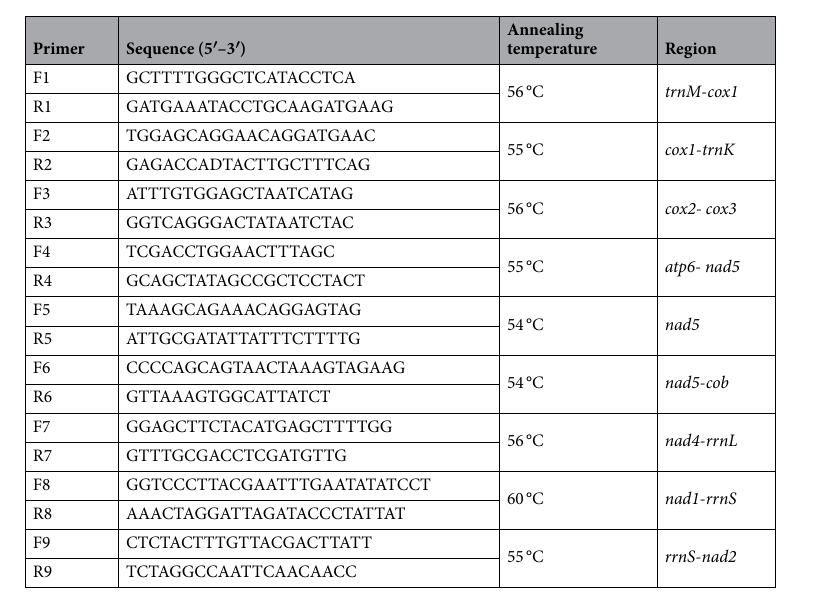
Table 2. Primers used in this